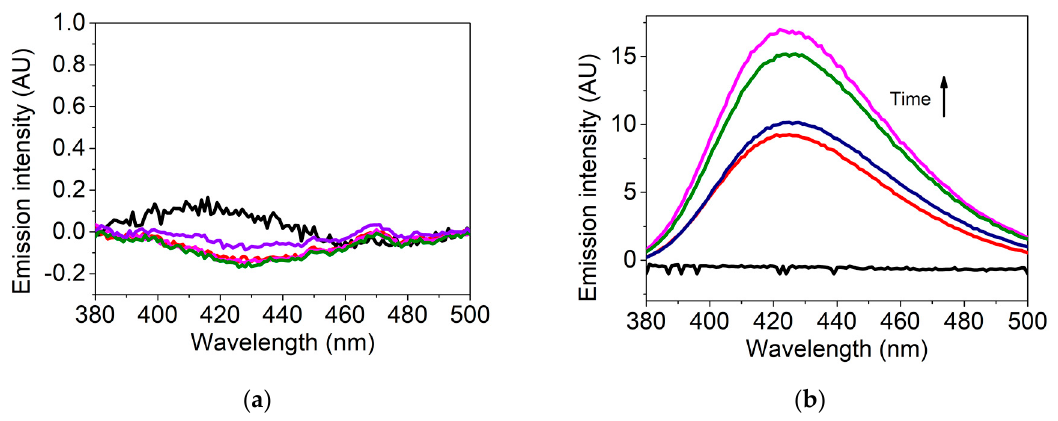
Figure 8. Emission spectra of a solution of terephthalic acid (0.5 mM in 2 mM aqueous NaOH) and 0.5 g/L of Ag 3 PO 4 cubes ( a ) or TiO 2 ( b ), recorded at different irradiation times: 0 (black), 15 (red), 45 (blue), 60 (green), and 120 min (pink). ( λ exc = 315 nm).